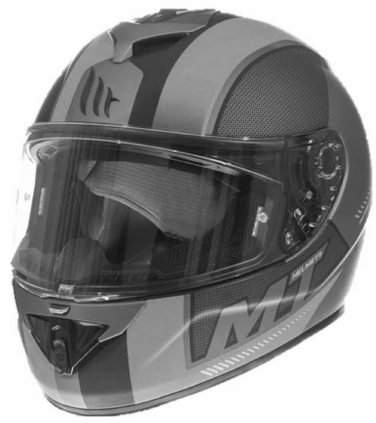
Figure A1. MT FF104 RAPIDE full-face helmet.